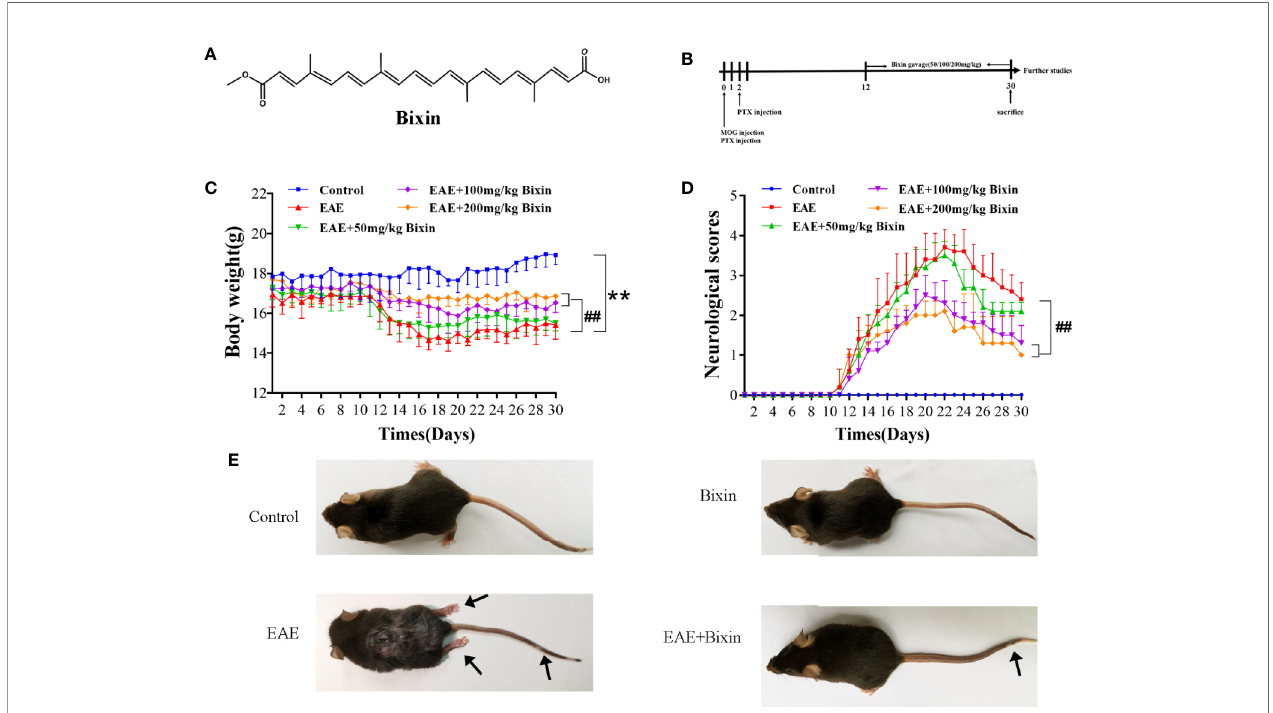
FIGURE 1 | Bixin attenuates the symptoms of EAE mice (A) . Chemical structure of bixin (B) . Study procedure (C) . Body weight and (D) clinical behavior scores of the EAE mice (E) . Representative images show behavioral symptoms of EAE mice in each group. Black arrows present limp tail or hind limb paralysis. Data shown in graphs represents the means ± SD (n = 5). **P < 0.01, vs. control group; ## P < 0.01, vs. EAE